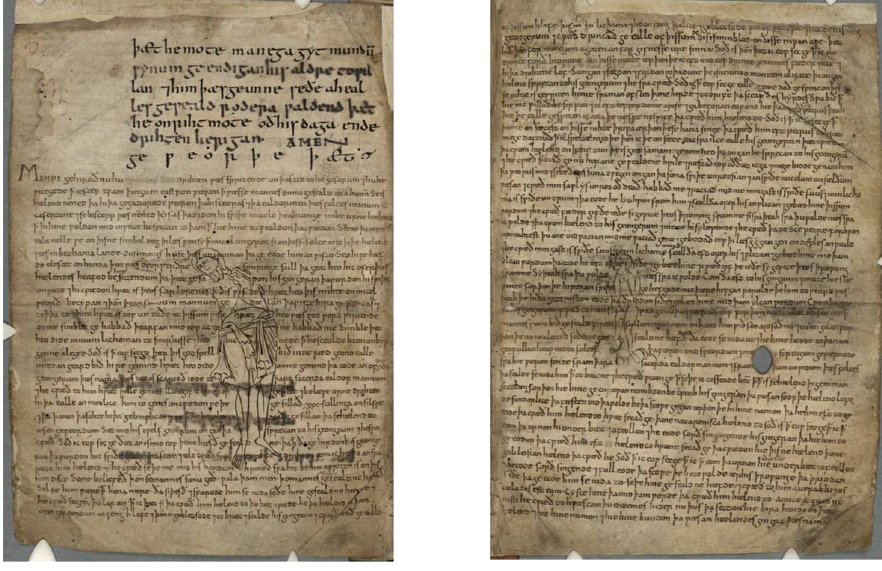
Figure 1. CCCC 41 (pp. 484–85).